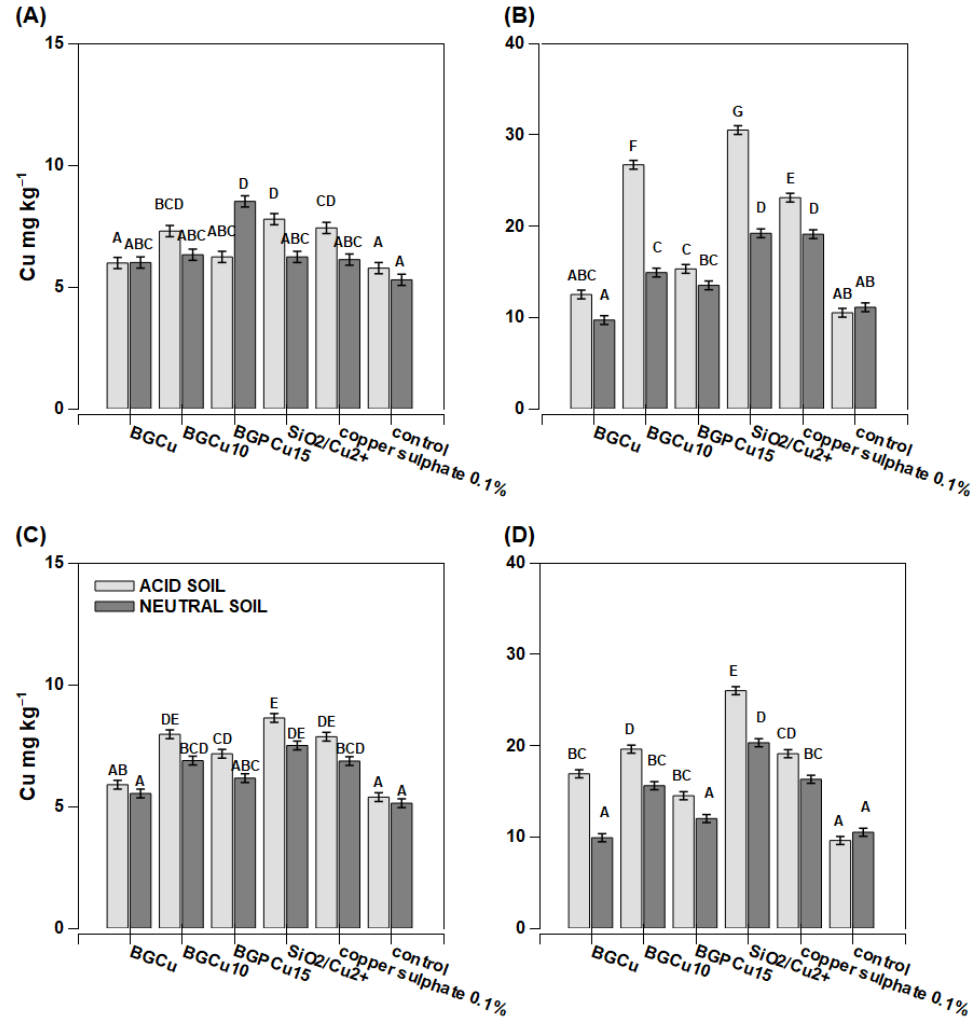
Figure 10. Copper concentration in winter rape Brassica napus L. var napus plant parts after foliar application of fertilizer. Grey bars for acid, dark grey for neutral soil. Bars marked with the same letters represent homogenous groups after Tukey’s test at p < 0.05 and error bars represent standard error (n = 4). ( A ) In whole plant—preparation applied on one leaf; ( B ) in one leaf sprayed; ( C ) in whole plant sprayed; ( D ) in leaf cut from whole sprayed